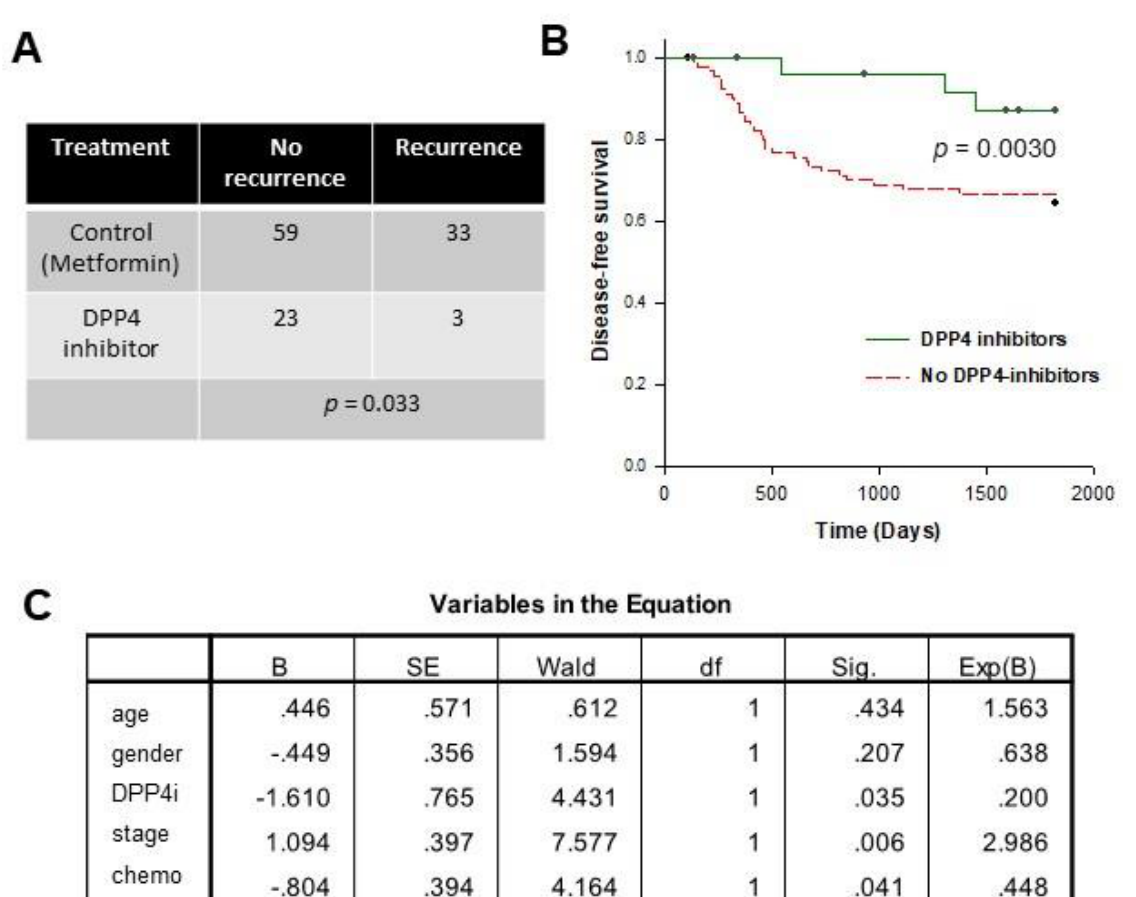
Figure 2. DPP4-inhibitors improve the prognosis of post-operative CRC patients. ( A ) There was a significantly lower rate of recurrence in DPP4-inhibitor-treated post-operative CRC patients when compared to the control group (metformin). ( B ) The DPP4-inhibitor-treated post-operative CRC patients showed significantly better disease-free survival when compared to the control group (metformin). ( C ) Cox regression analysis showed that DPP4-inhibitor and post-operative chemotherapy were favourable prognostic factors, whereas the high stage was an unfavourable prognostic factor for recurrence. Table 1. Clinical parameters of patients involved in this study. * The tumor stage data of 1 patient in DPP4-inhibitor group and 1 patient in control group is unknown.